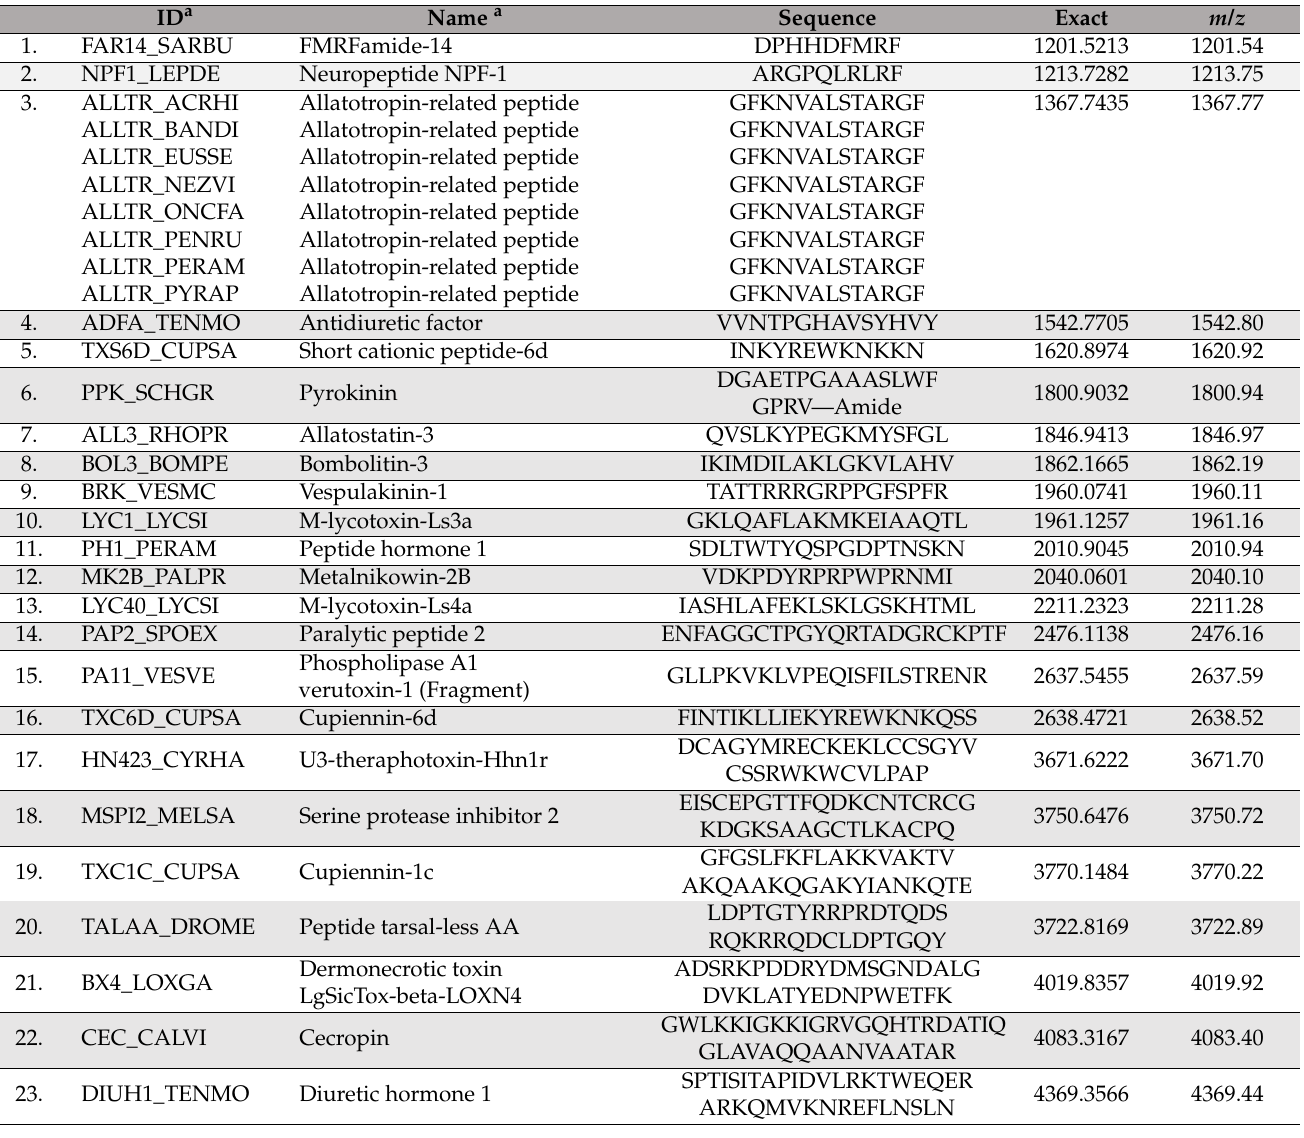
(Table S1). NeuroPIpred predictive tool was used to recognize the neuropeptides among those identified (https://webs.iiitd.edu.in/raghava/neuropipred/). Table 1. Identified proteins by MALDI MS/MS and Mascot software by Matrix Science